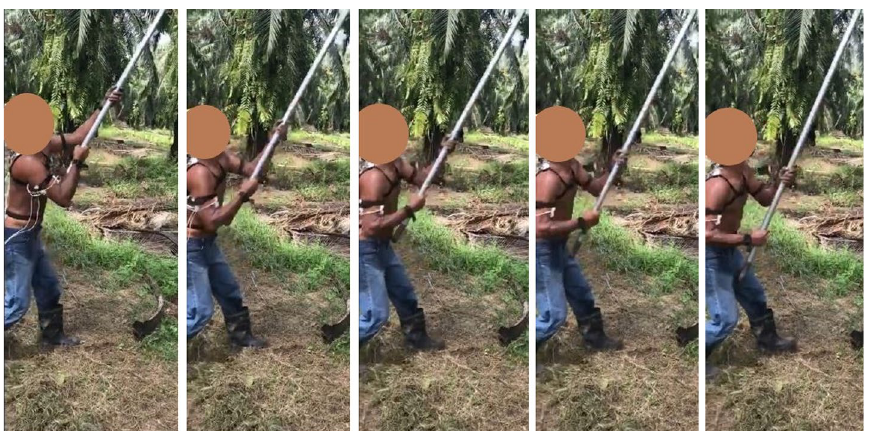
Figure 2. A sequence of the harvesting